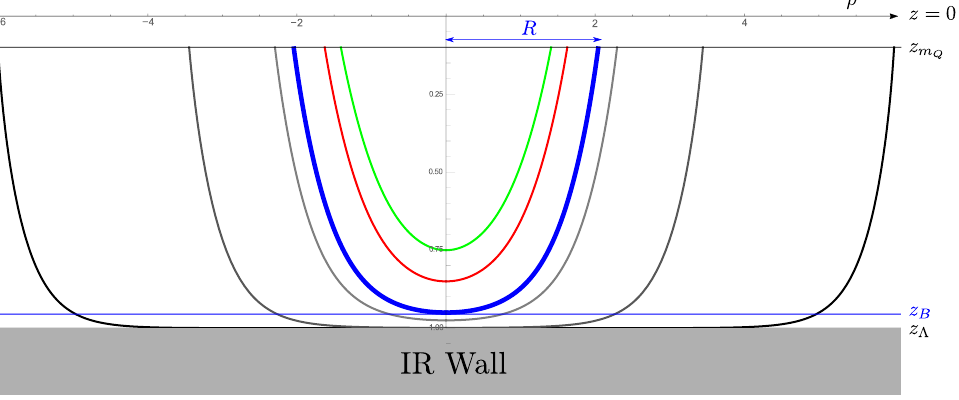
Figure 6 . One-parameter family of solutions of type ( I ) plotted for a mass m Q = 9 : 57 of the external quarks. Di(cid:11)erent solutions are parametrised by di(cid:11)erent distances between the quarks R , or equivalently, di(cid:11)erent distances from the bottom of the loop to the wall. For all the plots we have set z (cid:3) =